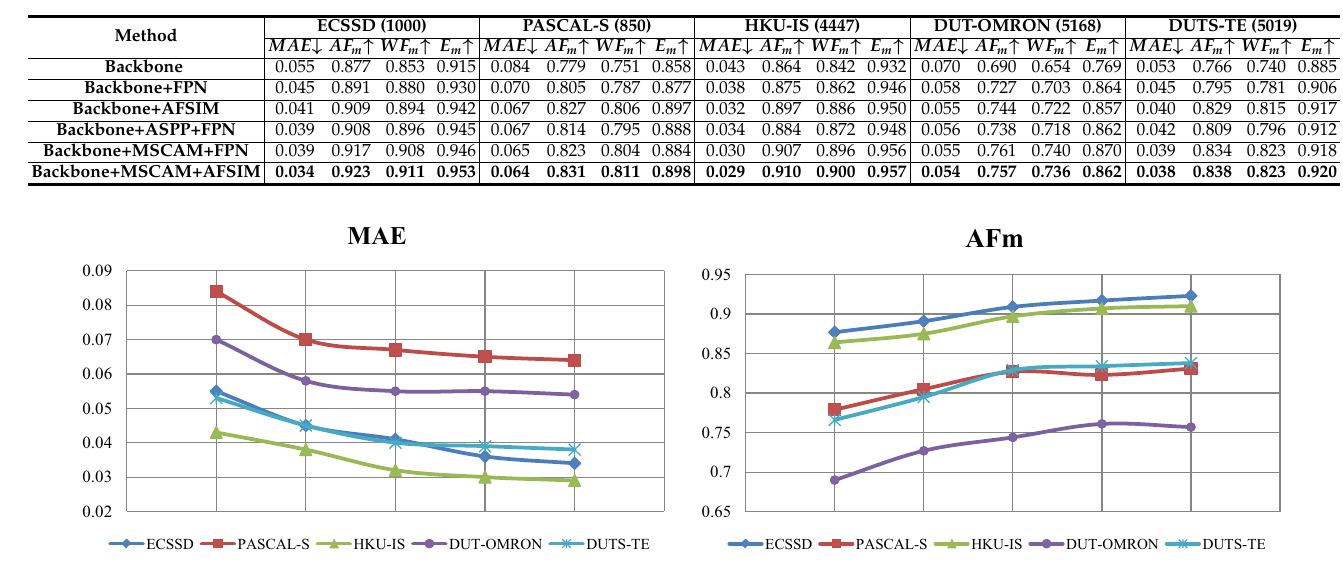
Table 3. Ablation analysis of our GSCINet method on ECSSD, PASCAL-S, HKU-IS, DUT-OMRON, and DUTS-TE datasets under four evaluation metrics. The symbols “ ↑ / ↓ ” indicate that the larger the result, the better, and the smaller the result, the better.